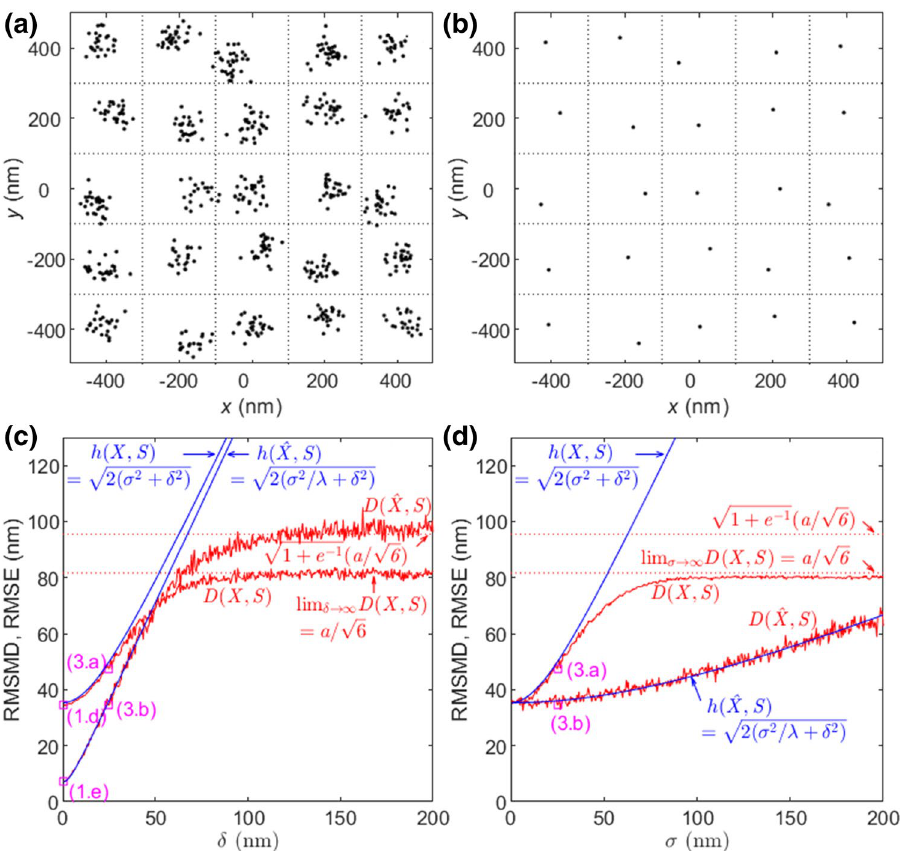
25 . ( a ) X with = X versus δ ˆ X with σ 25 nm and δ 25 nm. The ˆ = =